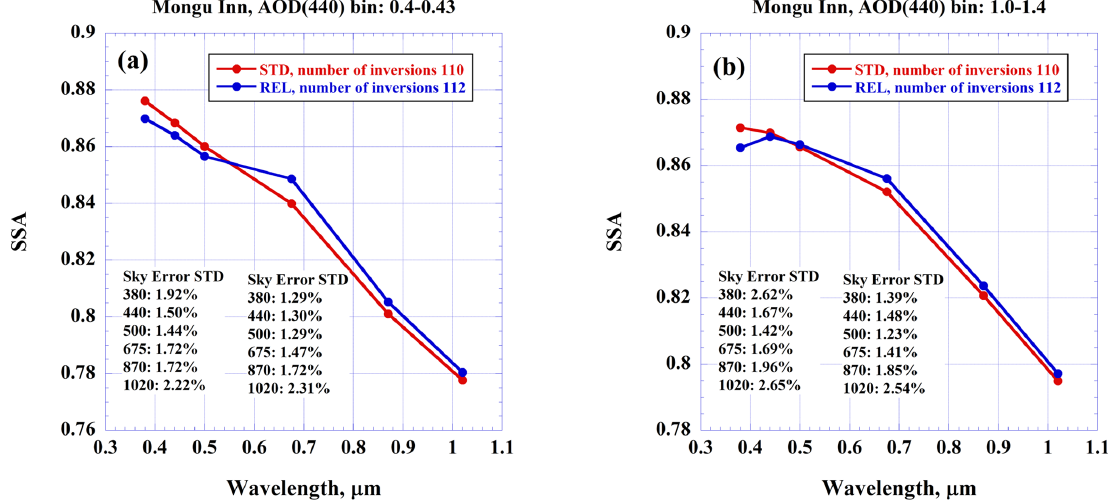
Figure 3. SSA averaged over AOD(440) bins for the Mongu Inn AERONET site: (a) 0.4–0.43 and (b) 1.0–1.4.